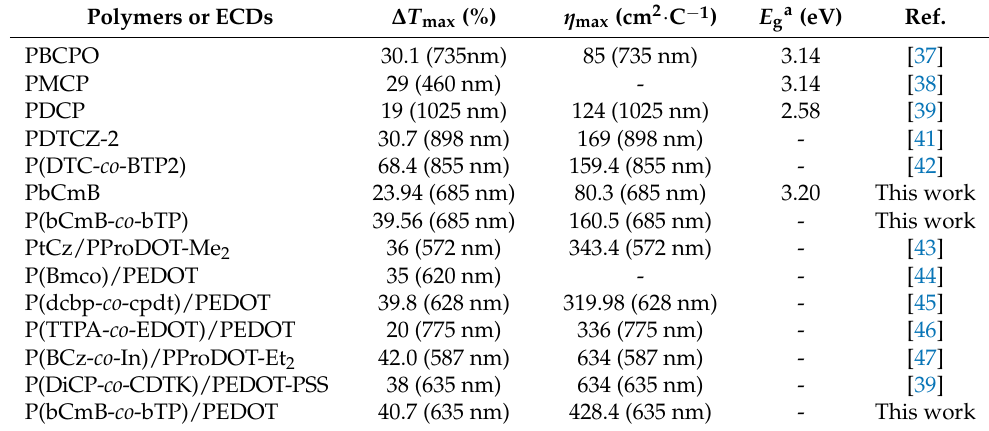
Table 3. Transmittance changes and coloration efficiencies of polymers (or